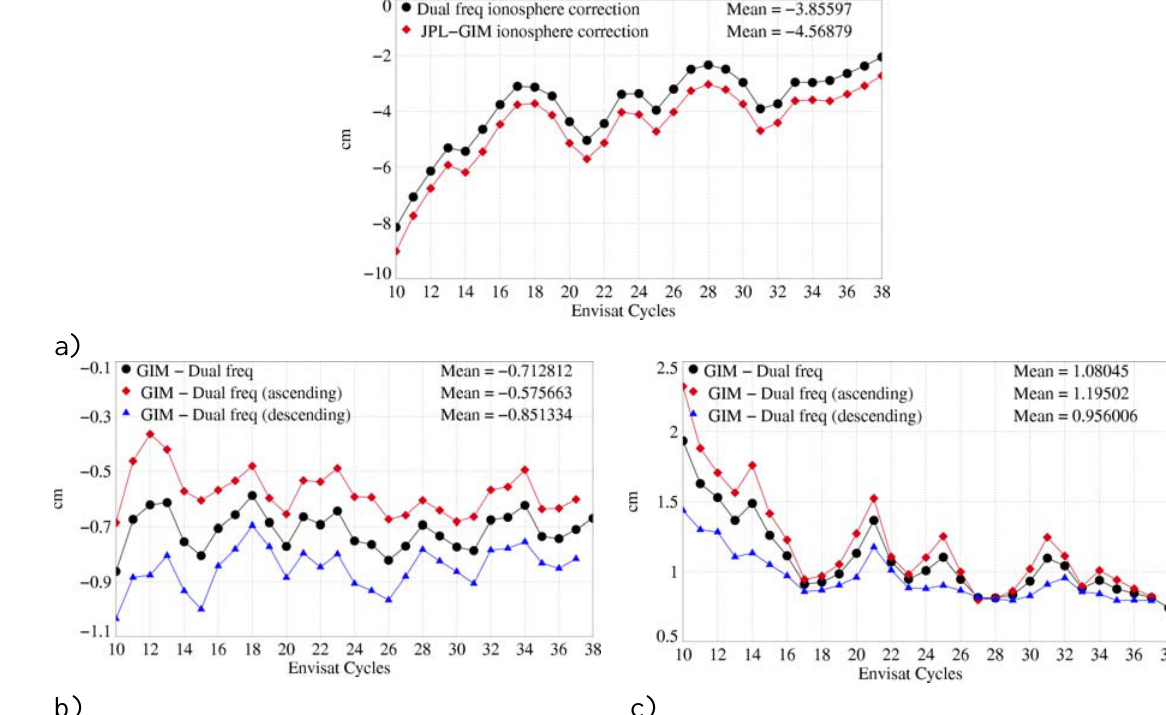
Figure 10. Comparison of global statistics of Envisat dual-frequency and JPL-GIM ionosphere corrections (cm). a) Cycle mean of dual-frequency and GIM correction. b) Mean of the differences c) Standard deviation of the differences.